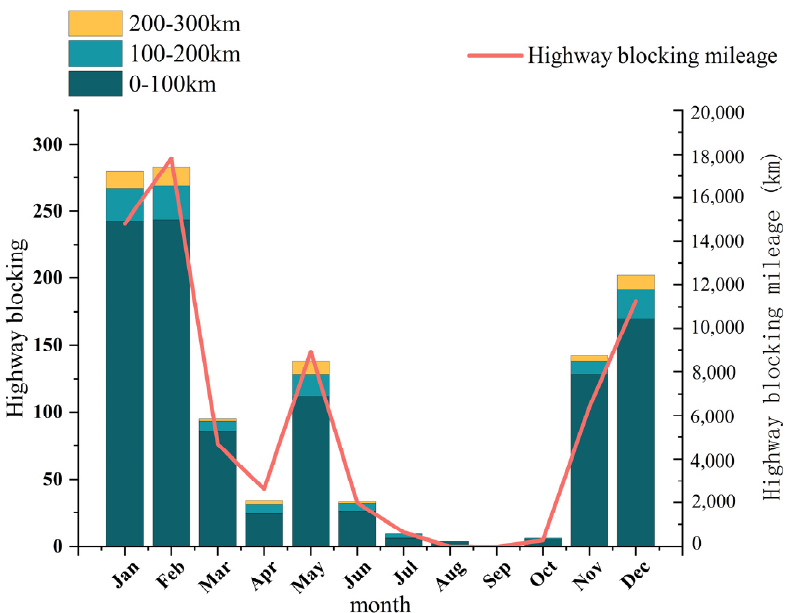
Figure 3. Annual variations of frequency (bars) and mileage (line) of highway-blockage events in Jiangsu Province in 2020.